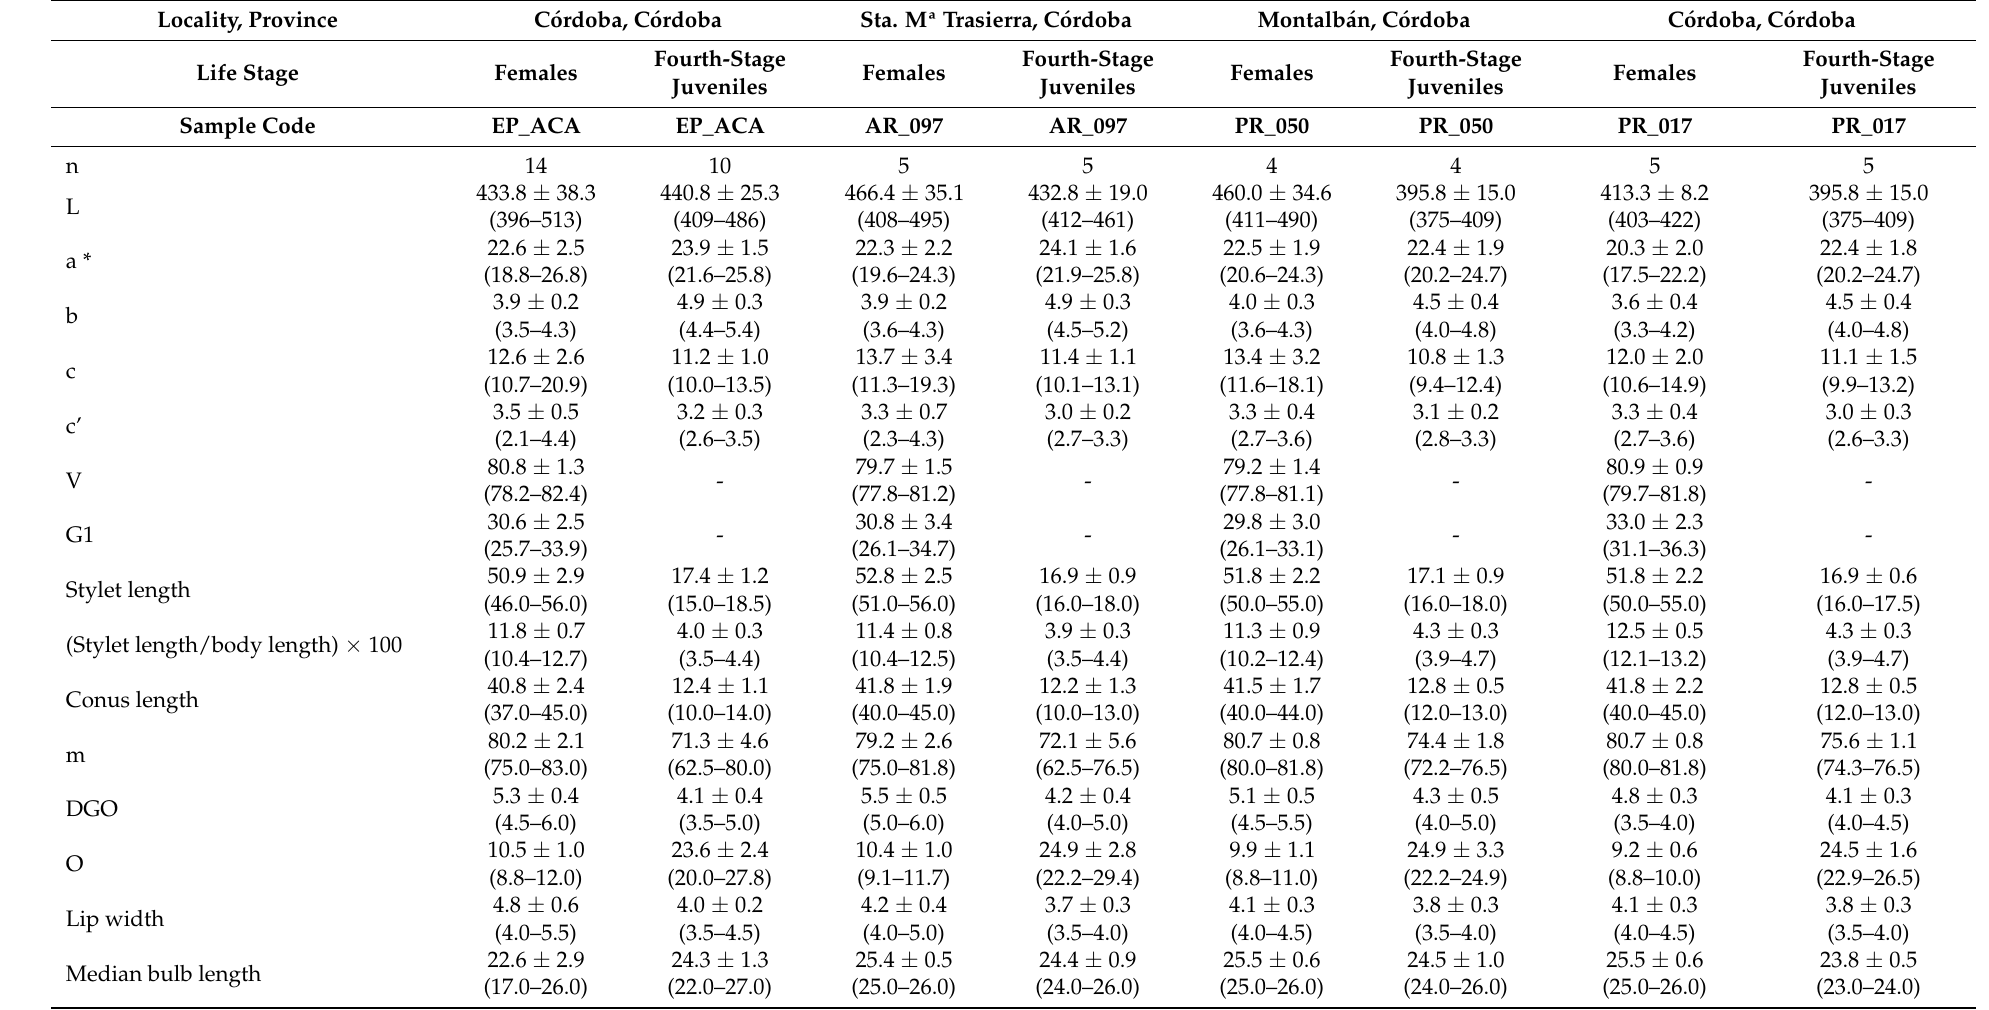
Table 6. Morphometrics of Paratylenchus goodeyi Oostenbrink, 1953 from several localities in Spain. All measurements are in µ m and in the form: mean ± s.d.